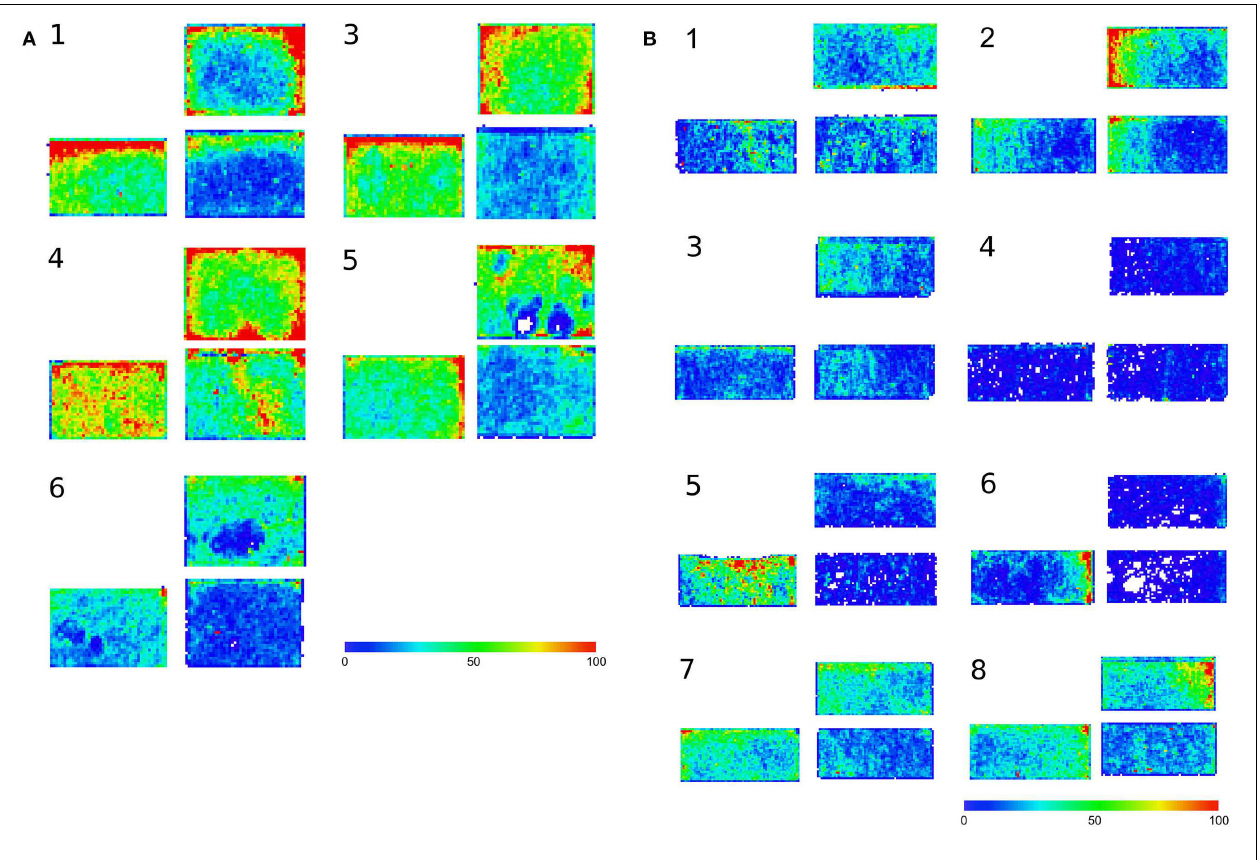
FIGURE 3 | Heat maps showing number of times any ant entered a small grid square during 5min. (A) Earth. (B) Space. 3 maps are shown for each replicate trial. Each small grid square is 1.9mm on the